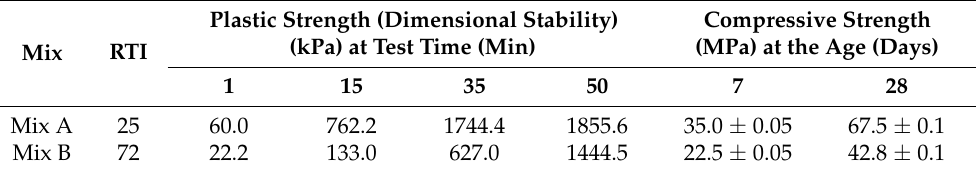
Table 12. Relationship between rheological and strength characteristics of a mortar.